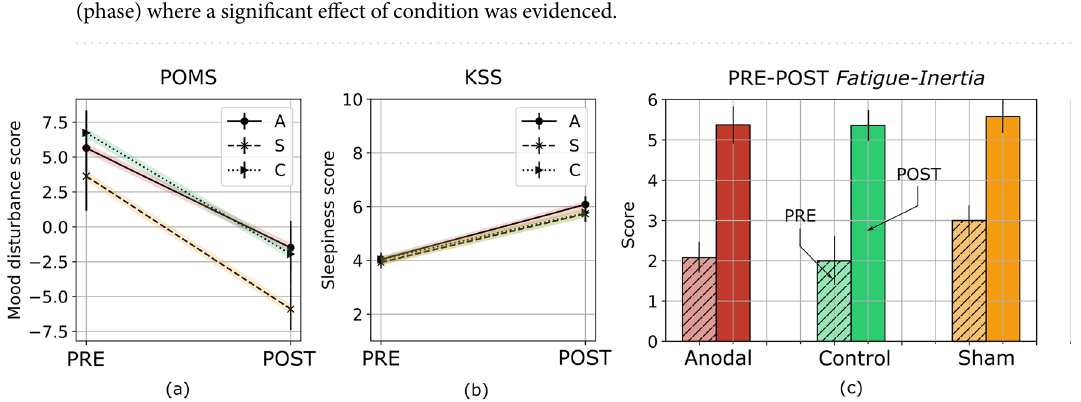
Figure 5. PRE- and POST- ( a ) mood disturbance and ( b ) sleepiness levels across all conditions as assessed by the Profile of Mood States survey and the Karolinska sleepiness scale. ( c ) PRE- and POST- fatigue-inertia scores from the POMS